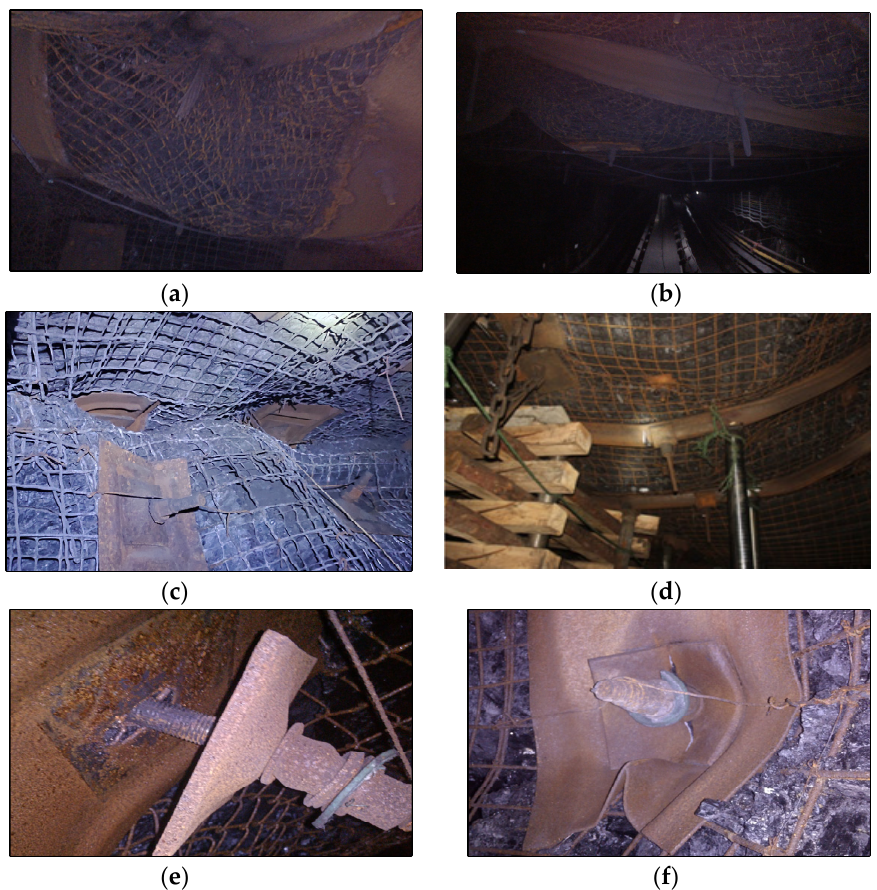
Figure 2. Deformation and failure of surrounding rock of roadway; ( a ) Roof bulging; ( b ) Appear “net pocket”; ( c ) Buttock shear slip; ( d ) Sinking roof; ( e ) Anchor bolt (rope) breakage.; ( f ) Pallet out–turning deformation.